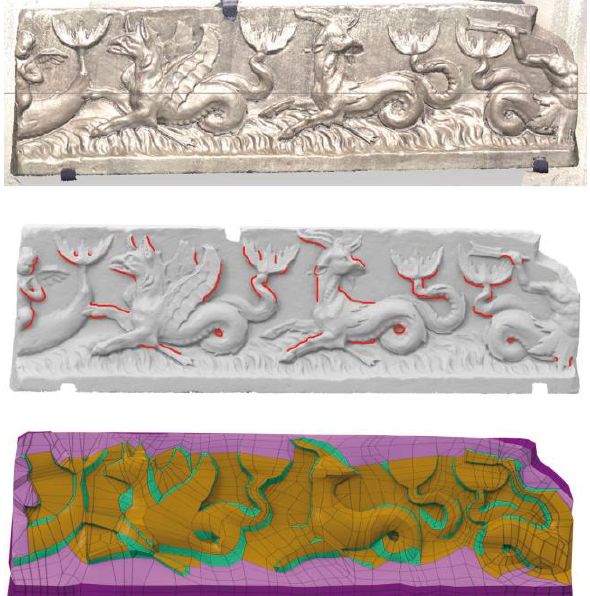
Figure 1. Marble frieze from the Hadrian’s Villa antiquarium: (a) mesh model from active sensor, (b) identification of the main features, (c) quad-dominant mesh obtained through manual retopology (Fantini, 2010).